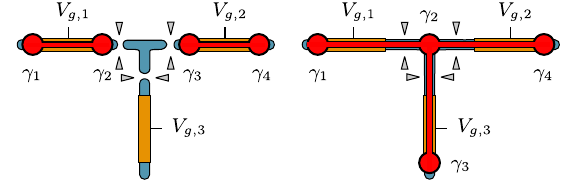
FIG. 18. T-junction geometry consisting of three mesoscopic superconducting islands coupled through a three-terminal junc- tion involving three pincher gates. Left diagram: If all three pincher gates are closed, the islands are decoupled and host a pair of Majoranas each. In dispersive read-out, tuning V used to measure the parities i γ 1 γ 2 and i γ 3 γ 4 , respectively. Right FIG. 16. Two Majorana Cooper pair boxes connected to the diagram: Opening the right and bottom pincher gate while tuning same bulk superconductor with Josephson energies E and E , J; 1 J; 2 the bottom island into the Majorana regime moves γ 3 to the and top gate voltages V and V , respectively. The islands are g; 1 g; 2 bottom island. Subsequently, opening the left pincher gate connected through the spin-polarized conducting channel, in connects all three islands, where γ 2 is shared by all islands in which the interisland transmission probability τ can be tuned by a the three-terminal junction. Connecting any of the top gates to a pincher gate. resonant circuit allows for dispersive read-out of the total parity − γ 1 γ 2 γ 3 γ 4